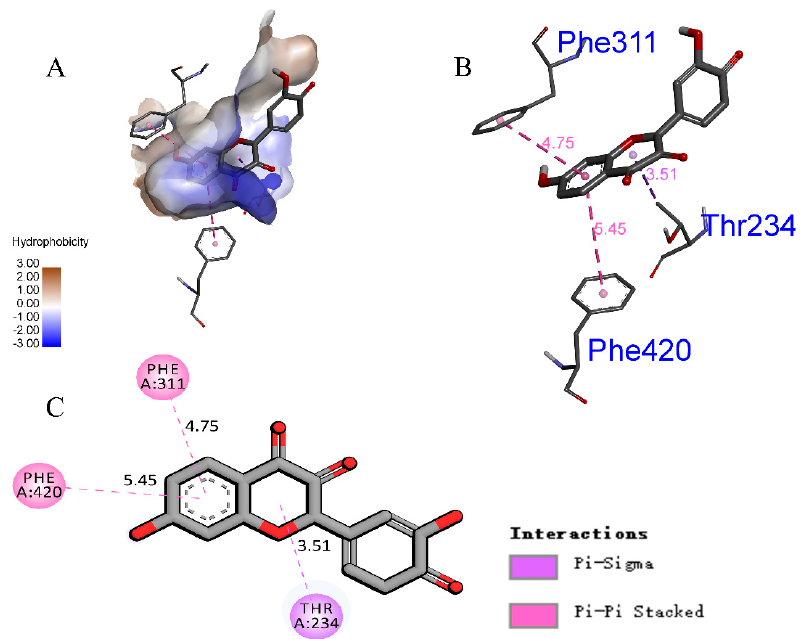
Figure 8. Molecular docking analysis of α‐ glucosidase. ( A ) Hydrophobicity of fisetin docked with α‐ glucosidase. ( B ) 3 ‐ D interaction between fisetin and α‐ glucosidase. ( C ) 2 ‐ D interactions of fisetin in the binding pocket of the developed homology model of α‐ glucosidase.